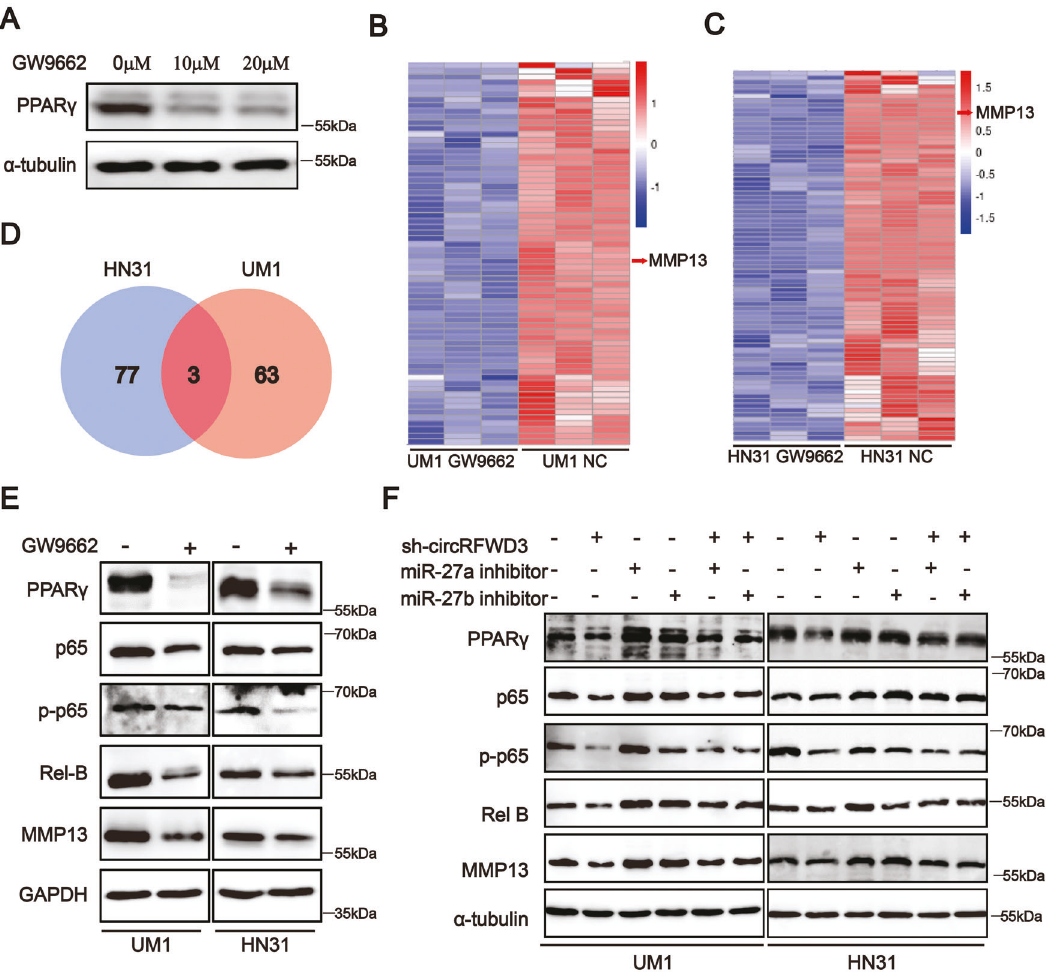
Fig. 6 CircRFWD3 regulated PPAR γ /NF- κ B/MMP13 signal pathway via miR-27a/27b in HNSCC. A Western blot showed that PPAR γ expression was decreased after GW9662 treatment in HN31 cells. B , C Clustered heatmap of a signi fi cant differentially expressed gene in UM1 and HN31 cells treated by GW9662. Each sample contained a mixture of three repeats. D Venn diagram showed MMP13, STRA6, and PTPRH were downregulated after GW9662 treatment in both HN31 and UM1 cells. E Western blot analysis showed inhibition of PPAR γ could decrease the expression level of p65, p-P65, Rel B, and MMP13. F Rescue analysis indicated that miR-27a and miR-27b inhibitors could alleviate the reduction of PPAR γ , p65, p-P65, Rel B, and MMP13 by inhibiting the expression of circRFWD3. Data were shown as representative of one experiment with three independent biological